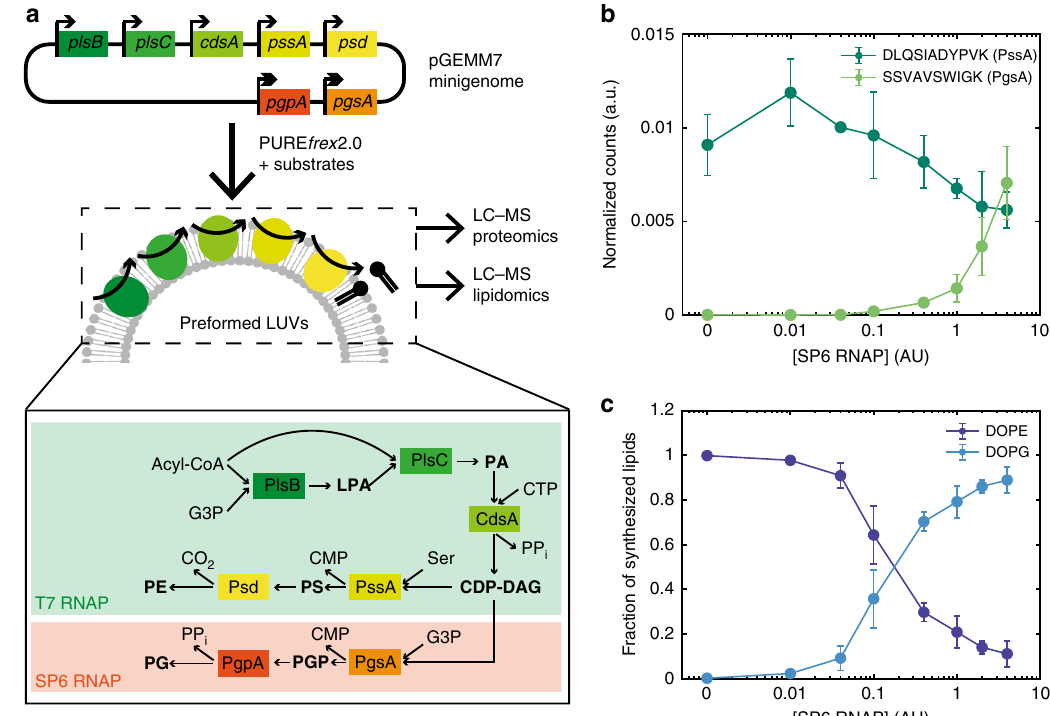
Fig. 1 Genetically controlled production of PE and PG by de novo synthesized enzymes. a The pGEMM7 plasmid contains seven genes encoding E. coli lipid synthesis enzymes. Transcriptional regulation over the production of PE and PG lipids is provided by controlling the expression of speci fi c enzymes with the orthogonal T7 (single arrow) and SP6 (double arrow) promoters. The main reaction products are in bold and the enzyme names are squared. The PgsA – PgpA branch of the pathway, which leads to PG synthesis, is activated upon addition of the SP6 RNAP. An acyl-CoA, the heavy isotope of G3P, CTP, and serine (Ser) are the input substrates. Expression of pGEMM7 with PURE frex 2.0 occurred in the presence of preformed LUVs. Protein and lipid production was monitored by LC-MS. PPi, pyrophosphate. b LC-MS analysis of cell-free synthesized proteins. Normalised integrated peak intensity for representative peptides of PssA and PgsA, the fi rst enzymes after the pathway branches out, for a range of SP6 RNAP concentrations (given in activity units as de fi ned by the supplier, AU). Data are the mean ± SD of three independent experiments. c LC-MS analysis of de novo synthesized phospholipids. The fraction of synthesized DOPE and DOPG is plotted for a range of SP6 RNAP concentrations (in AU). Data are the mean ± SD of three independent experiments. Source data are available for ( b , c Orthogonality of the two promoter-RNA polymerase (RNAP)